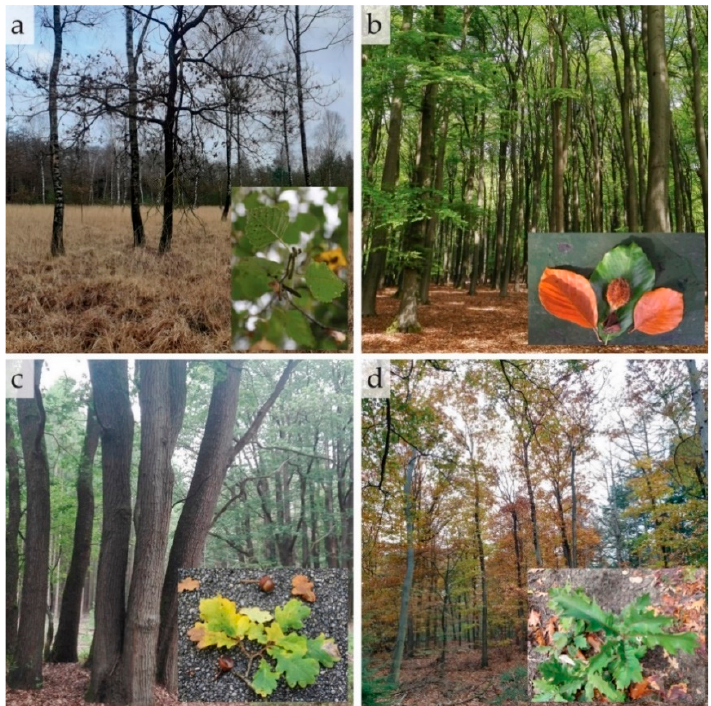
Figure A1. The general habitat appearance and foliage of the four angiosperm tree species used in the analysis with ( a ) silver birch ( Betula pendula ), ( b ) European beech ( Fagus sylvatica ), ( c ) common oak ( Quercus robur ), and ( d ) northern red oak ( Quercus rubra ). All photographs were made by the authors.